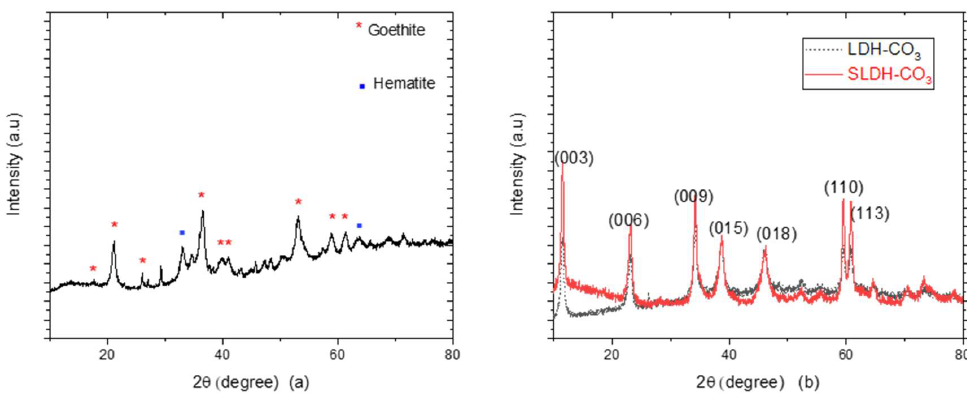
Figure 2. ( a ) Powder X-ray diffraction pattern of the Saltburn ochre. Characteristic reflection peaks from goethite can be observed as denoted by *; ( b ) powder X-ray diffraction pattern of the synthesized ochre derived LDH-CO3 and metal salt derived SLDH-CO 3 with characteristic diffraction peaks for layered double-hydroxide (LDH) structures.